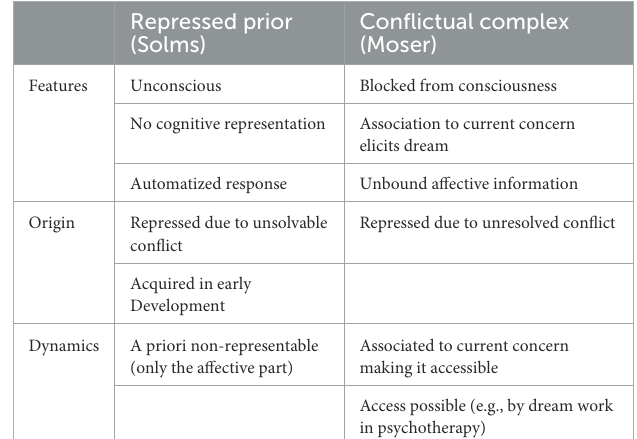
TABLE 1 Repressed prior and conflictual complex—comparison of core